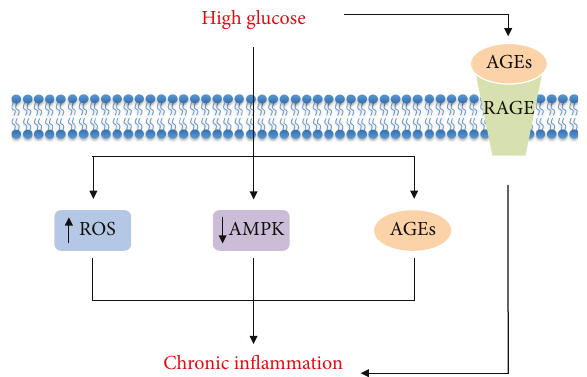
Figure 1: Main mechanisms by which glucose excess induces chronic in fl ammation. AGEs: advanced glycation end products; AMPK: AMP-activated protein kinase; RAGE: receptor for AGEs; ROS: reactive oxygen